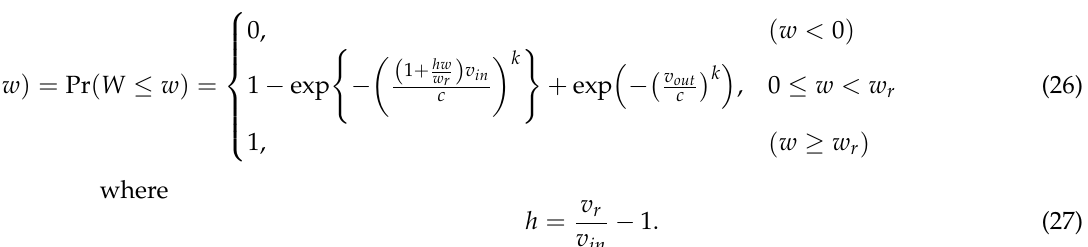
Figure 8. Three-dimensional Weibull PDF vs. wind speed and shape factor. ( a ) c = 10; ( b ) c = 20.